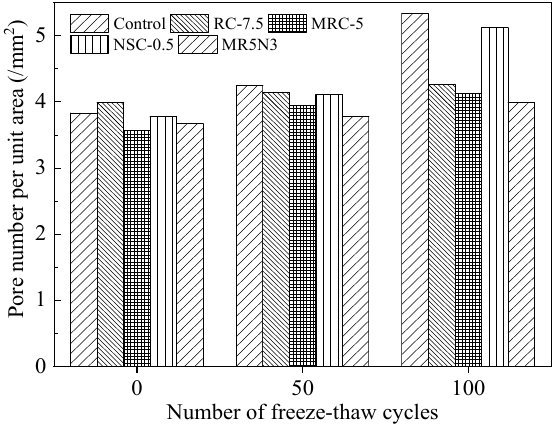
Figure 14. Influence of freeze–thaw cycle on pore number per unit area. Table 6. Increased rate of pore numbers under freeze–thaw cycles. Increased Rate of Pore Number (%) Mixture Freeze–Thaw Cycles Small Pore